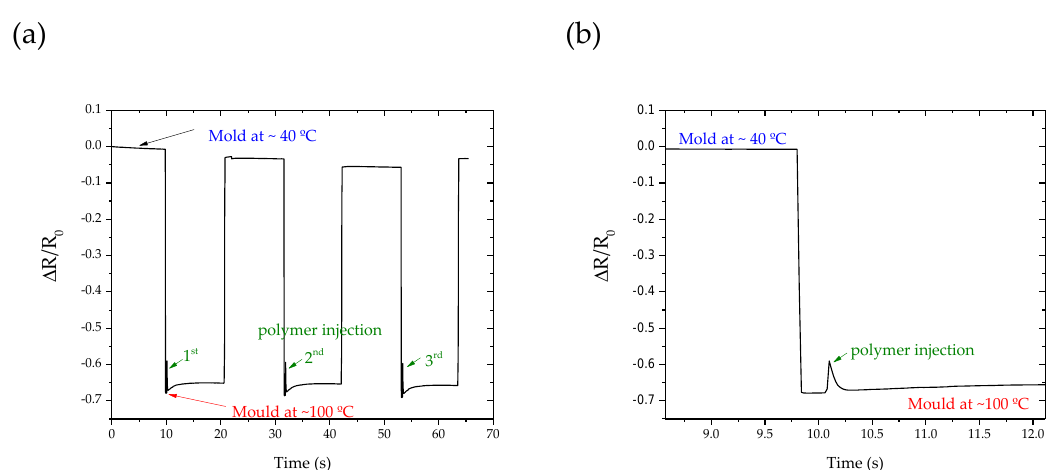
Figure 11. Electrical behavior of the integrated TiCu(O,N) system prepared with a flux of 2 sccm of N 2 + O 2 during successive injection cycles. ( a ): The first three injection cycles and in ( b ) a zoon of the 1 st injection cycle.